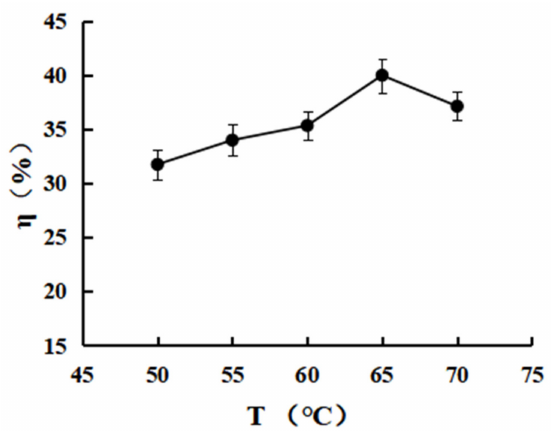
Figure 7. Effect of the reaction temperature ( ◦ C) on the grafting